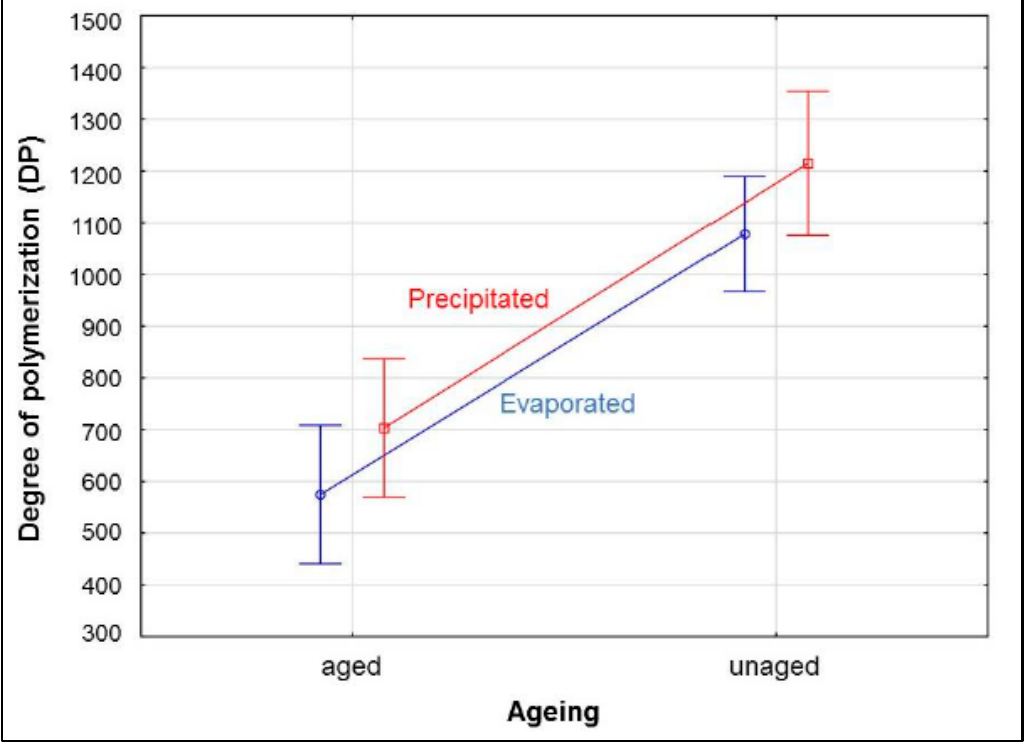
Figure 4. Influence of aging*method on the degree of polymerization in cellulose.